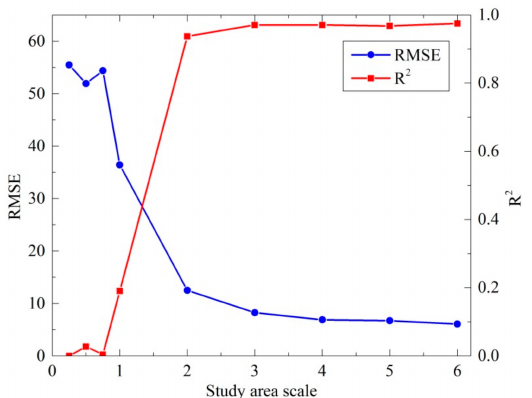
Figure 9. The R 2 adj and the RMSE between FR S for the whole 2100 × 2100 grid simulated landscape and the FC MA estimate for each of the 201 TSLF maps at each of the nine study area scales.